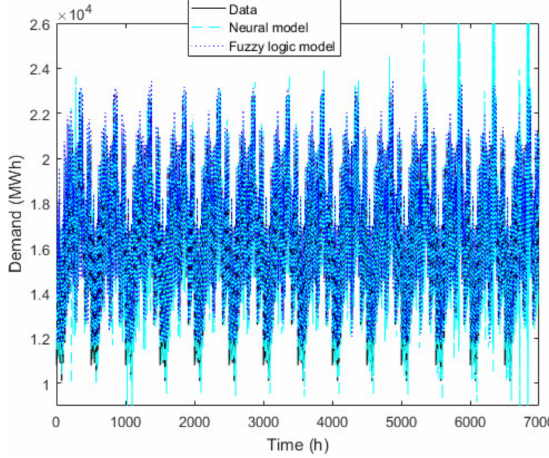
Figure 3. Training results of the first training dataset.